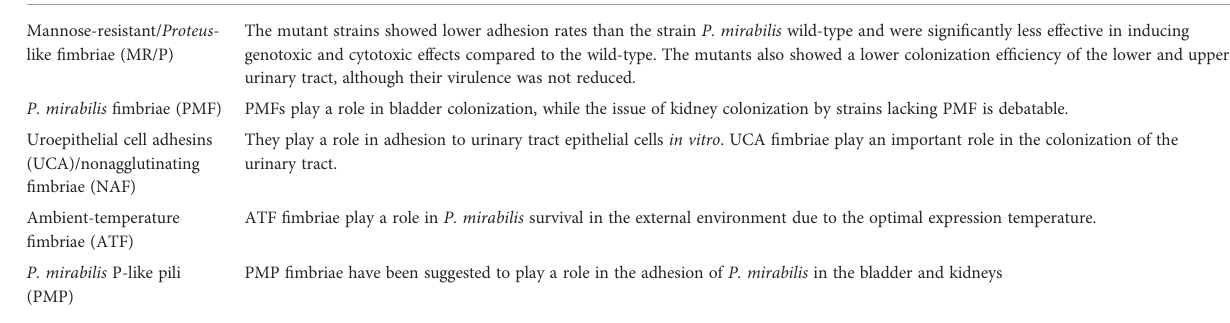
TABLE 1 Characteristics of most studied Proteus mirabilis fi mbriae.